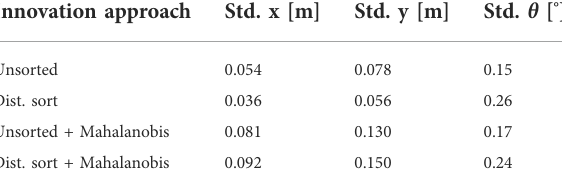
TABLE 3 Standard deviations from the localization system ’ s kidnapped robot tests — transient. Innovation approach